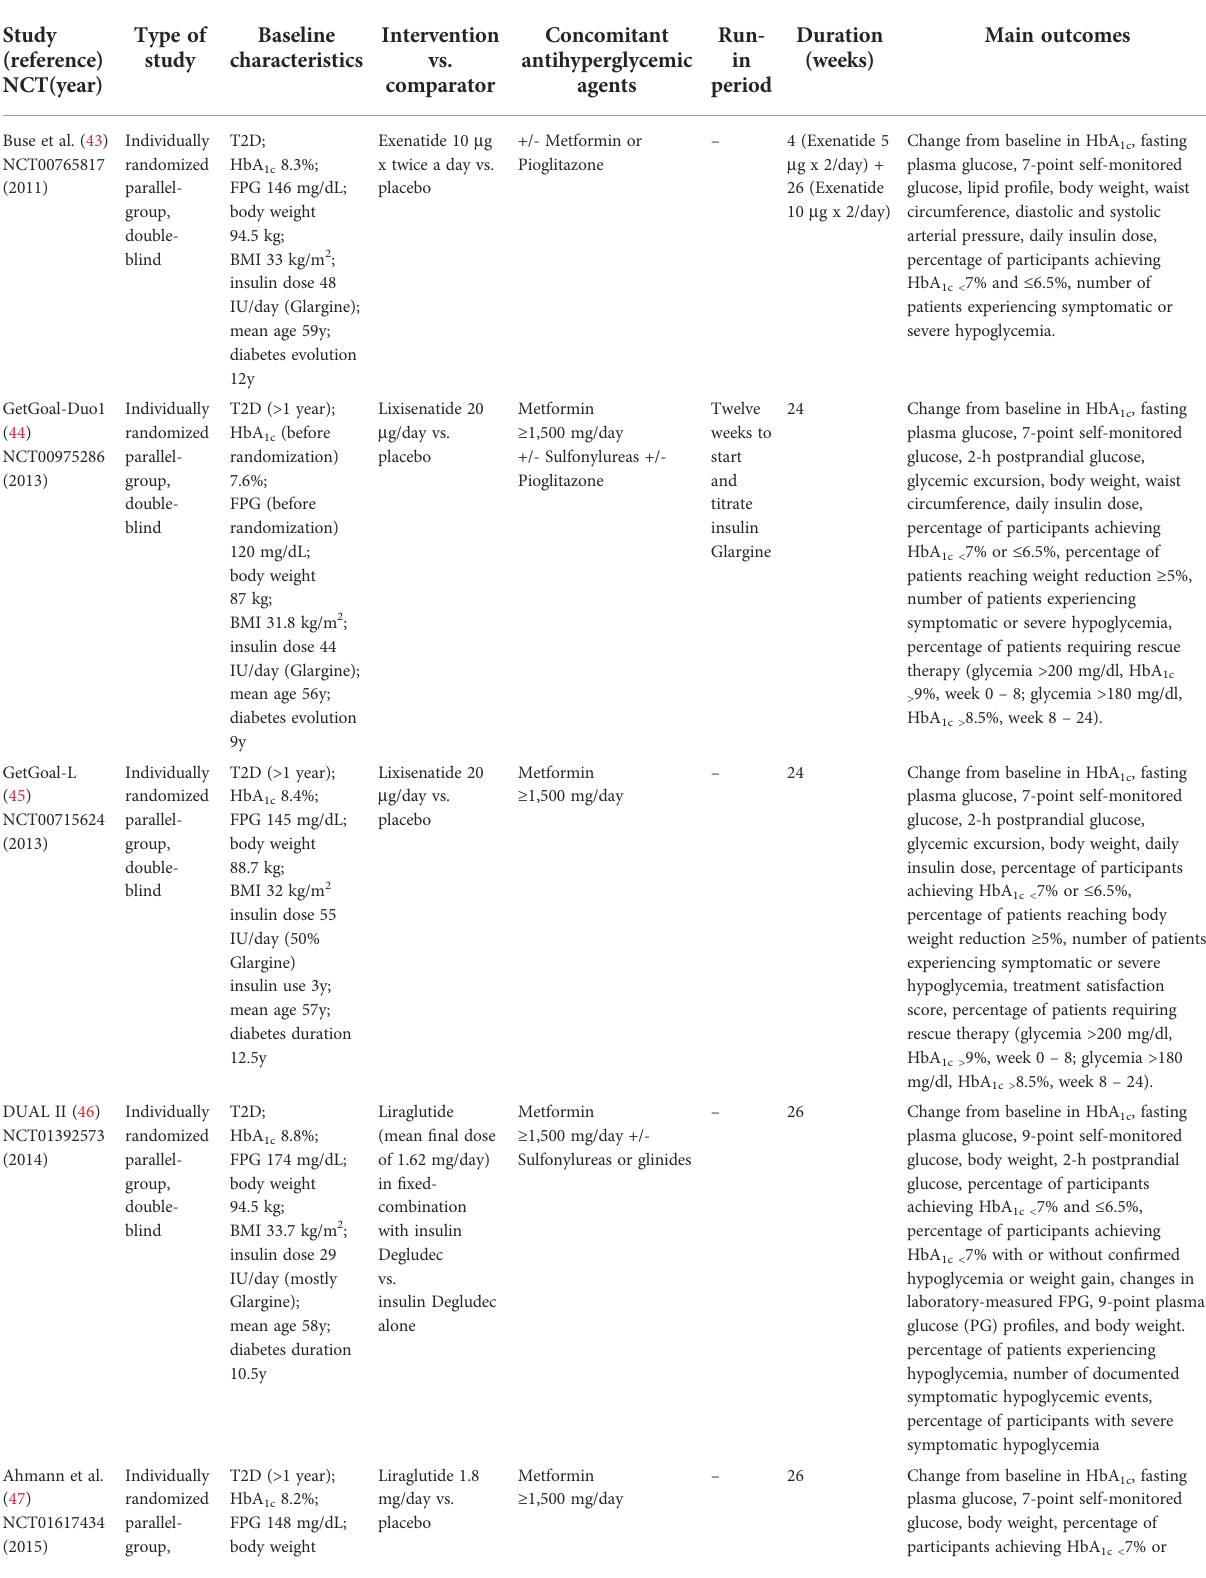
TABLE 2 Summary of RCTs included in the systematic